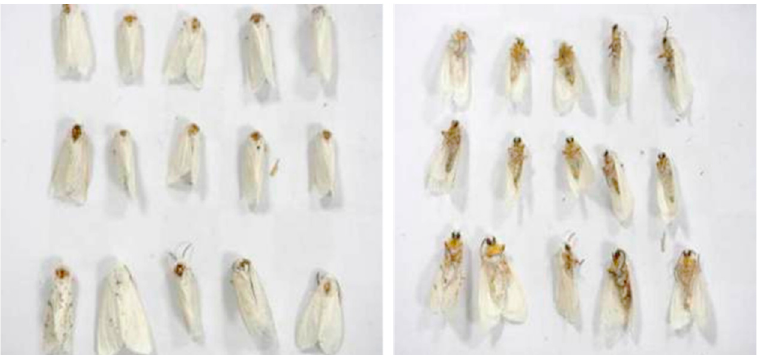
Figure 1. Samples of H. cunea in various poses. Different postures of wings ( left ), and different postures of torso ( right ).